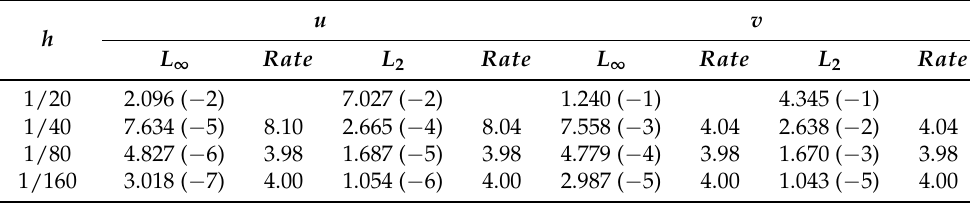
Table 3. The L ∞ error, L 2 error and convergence rate when a = d = s = 1, b = 100 for Problem 3. h